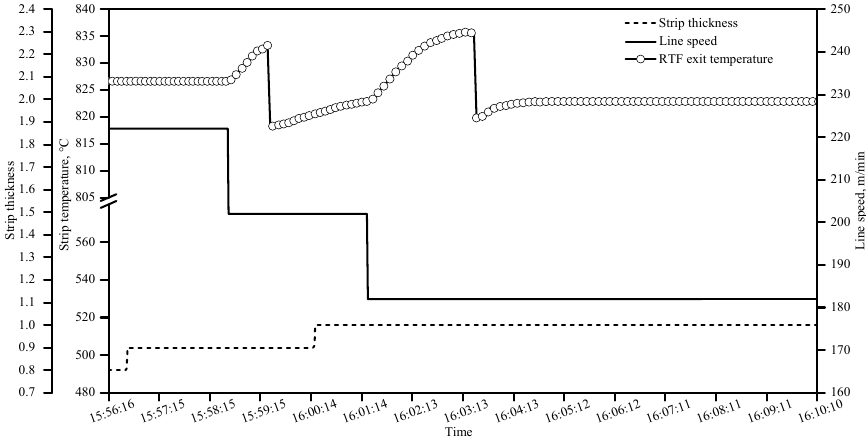
Figure 9. Response of strip temperature at RTF exit when both strip thickness and line speed change.